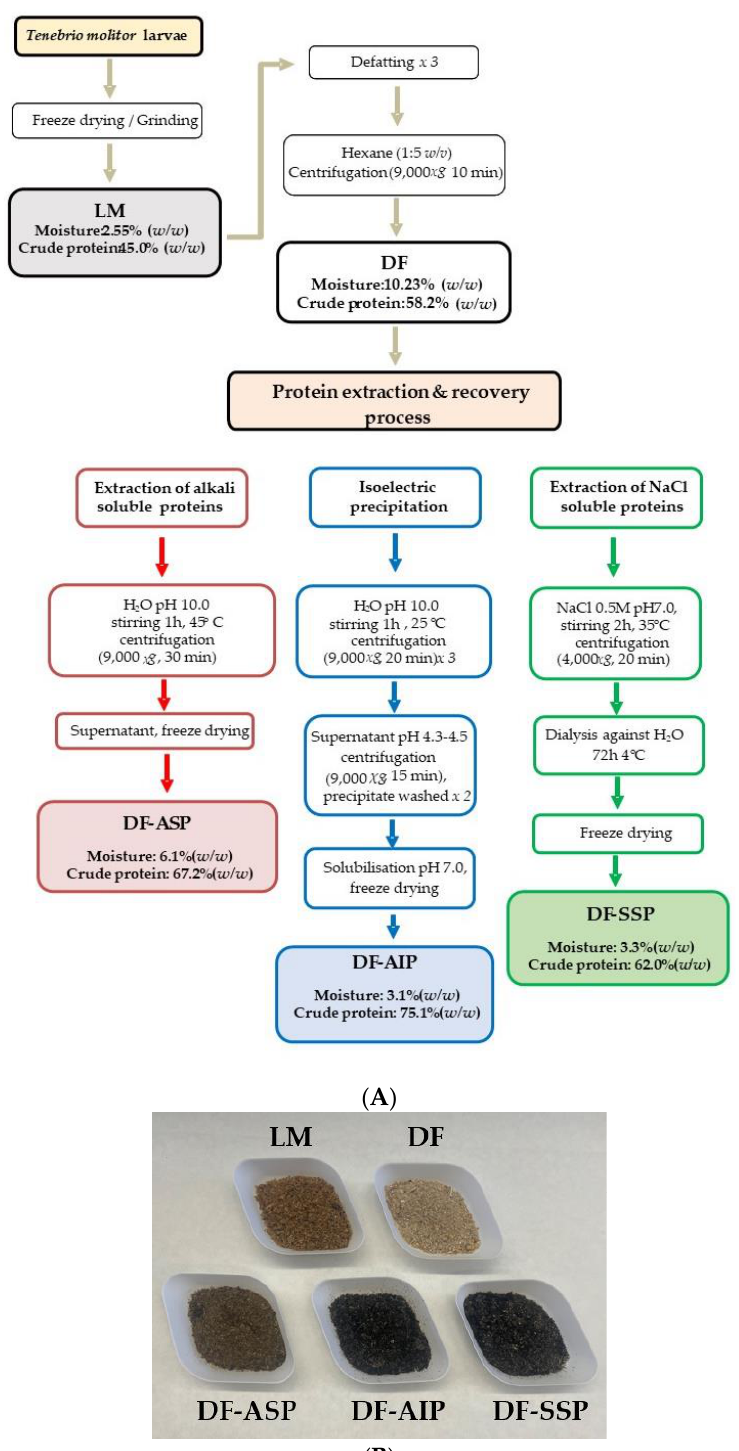
Figure 1. ( Α ) Flow diagram of T. molitor larvae protein extraction and recovery processes, and ( B ) photographs of the obtained larvae meal powder (LM), defatted powder (DF), and the protein preparations obtained with alkali extraction (DF-ASP), alkali extraction followed by isoelectric precipitation (DF-AIP), and salt assisted extraction (DF-SSP).